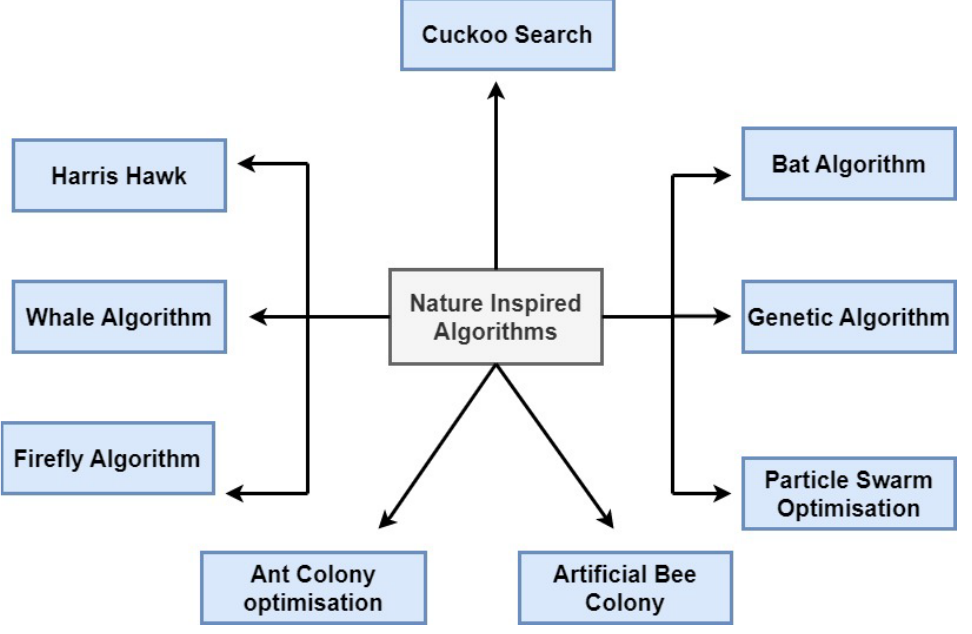
Figure 4. Widely used nature-inspired algorithms.